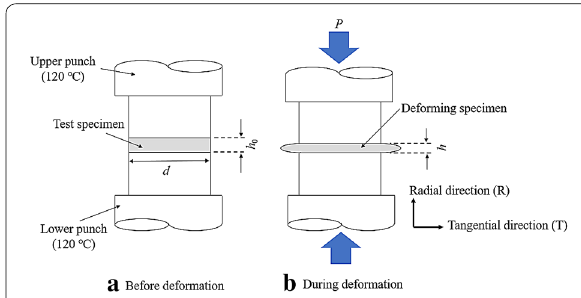
Fig. 2 Schematic diagram of free compression test. d : specimen diameter, h 0 : initial thickness, h : deformed